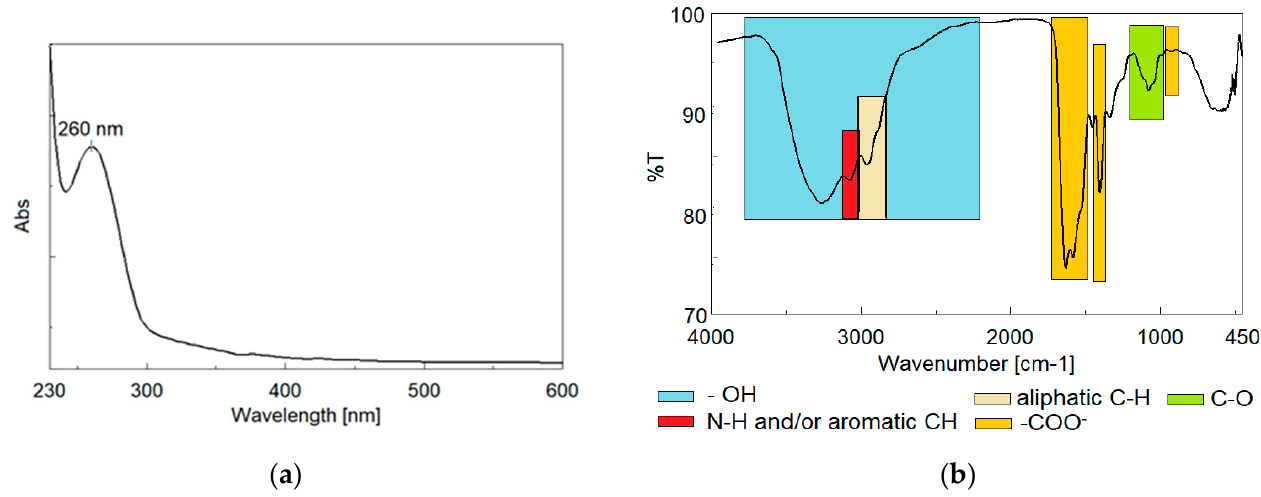
Figure 6. Spectroscopy analysis of biosurfactant: ( a ) UV-Vis; ( b ) FTIR. The FTIR spectrum (Figure 6b) recorded for the biosurfactant showed vibration bands characteristic of some aromatic amino acid compounds, confirming the UV-Vis data. Thus, the FTIR spectrum is characterized by a broad band between 2280–3700 cm − 1 due to the vibration of OH bonded from COOH [75]. This band also overlaps with characteristic vibrations of both N-H and aromatic bonds (3070 cm − 1 ) from amino acids [76] and aliphatic C-H bonds (2960 cm − 1 ) [77]. The multipeak band between 1480–1766 cm − 1 contains characteristic peaks of the carboxyl groups COO − (1581, 1575 cm − 1 ) [75], but also of the aromatic ring (1518—1540 cm − 1 ). Peaks characteristic of the COOH vibration from acids can also be observed at 1400 cm − 1 and 927 cm − 1 . The amide-type vibration from the amino acid is observed at 1331 cm − 1 , and the broad peak at 992–1175 is specific to the vibration of the C-O bond